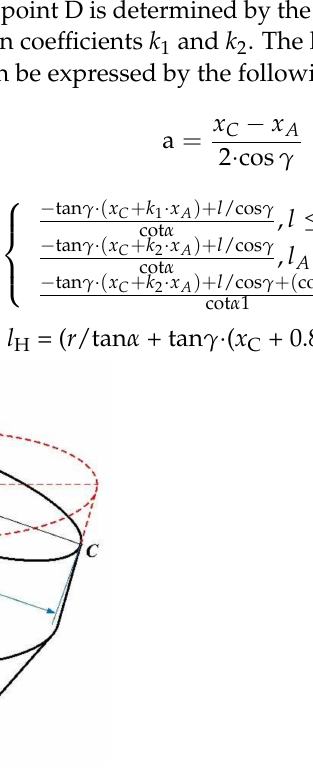
Figure 3. Schematic diagram of the long and short axes of the section